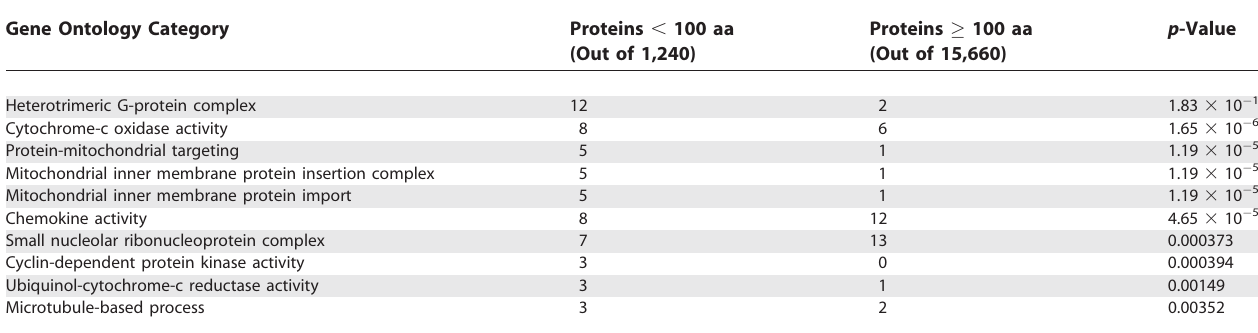
Proteins (cid:2) 100 aa p -Value (Out of 1,240) (Out of 15,660)